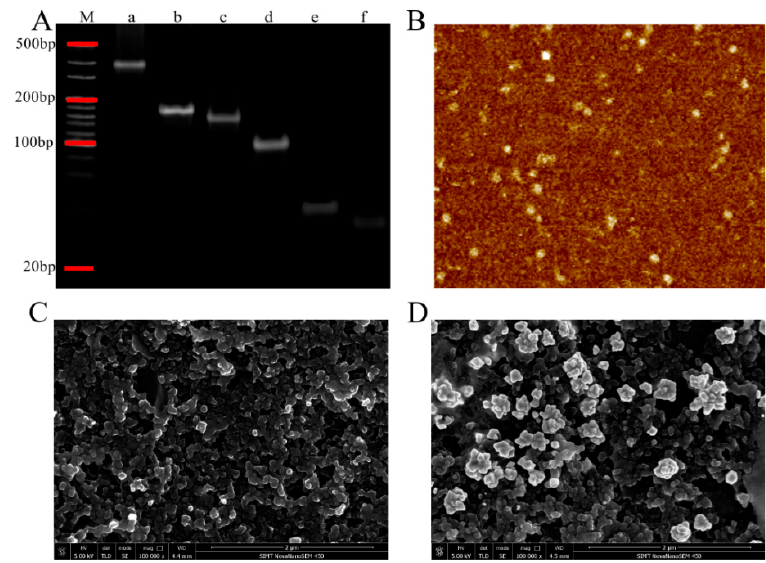
Figure 2. ( A ) Gel electrophoresis image of marker (lane M), tetrahedral-structured probes (TSPs, lane a), ABC (lane b), BCD (lane c), AB (lane d), A (lane e), and B (lane f). ( B ) Atomic force microscopy (AFM) image of TSPs. Scanning electron microscopy (SEM) results of ( C ) bare carbon electrode and ( D ) gold nanoparticles (AuNPs) electrode. The scale value was 2 μ m.